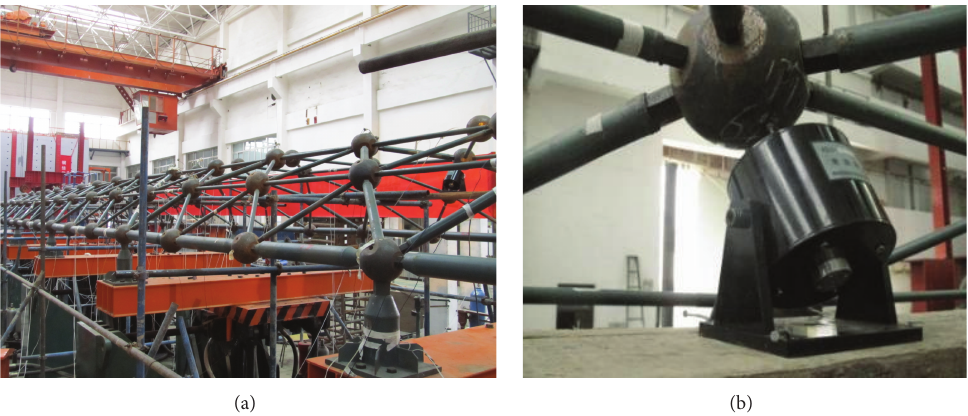
Figure 7: Test model field: (a) single-layer latticed cylindrical shell; (b) electromagnetic exciter using a 50N output.